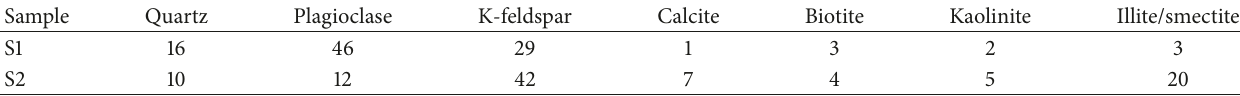
Table 1: Mineralogical compositions of the samples